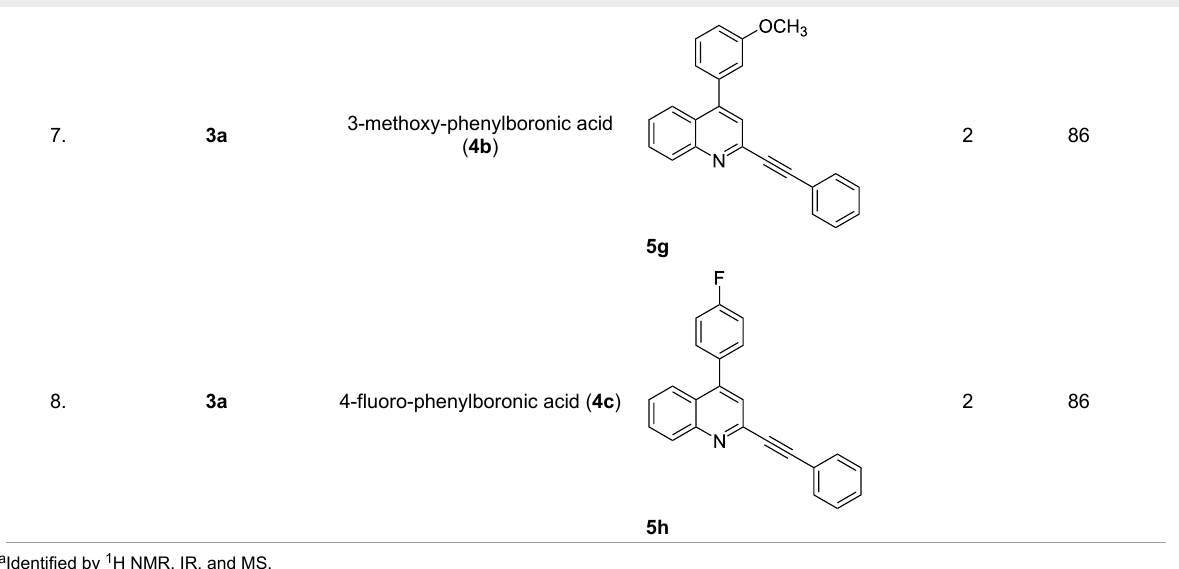
Table 2: Synthesis of 2-alkynyl-4-arylquinolines ( 5 ).